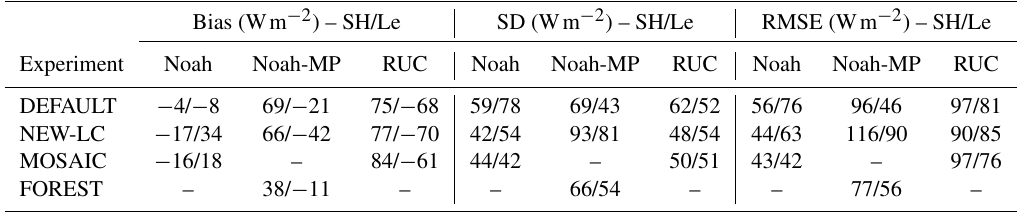
Table 3. Summary of the scores (Wm − 2 ) calculated for the evaluated area for each LSM (columns) configured for each experiment (raws). The first value refers to the sensible heat flux (SH) and the second one to the latent heat flux (Le). Some experiments were not possible (–) for some LSMs. The scores used are the bias (systematic error), standard deviation (SD) (random error), and the root mean square error